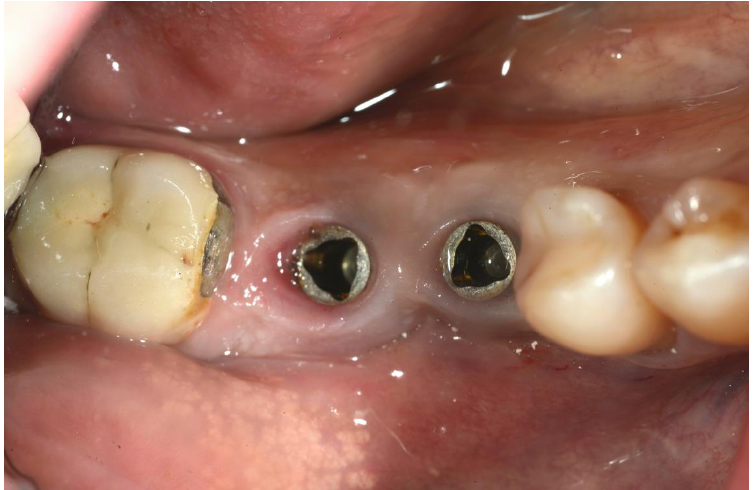
Figure 2. Preoperative image of the surgical area.